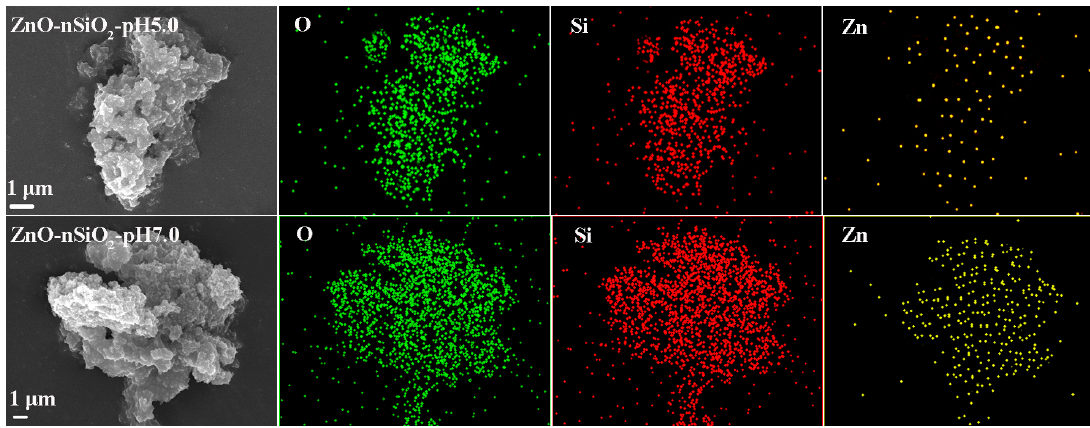
Figure 4. SEM images of ZnO–SiO 2 and corresponding mapping results.